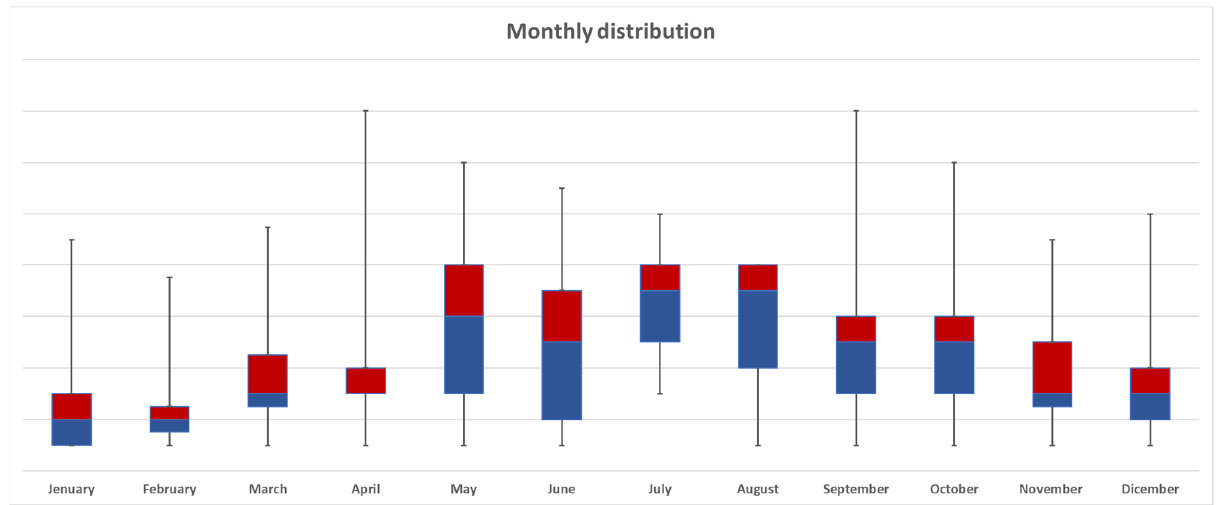
Figure 3. Overall monthly distribution of bike-related trauma, median and IQR graphic representa- tion. IQR: interquartile range.